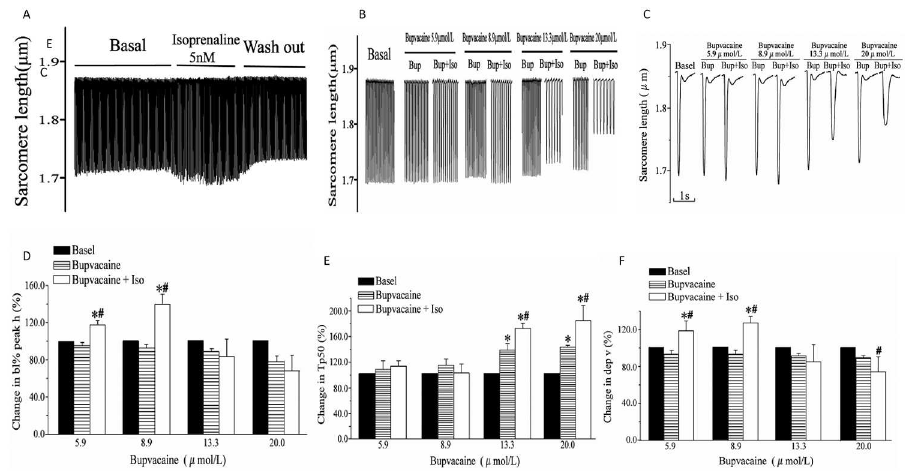
Fig 4. Effect of isoprenalin on bupivacaine-mediated depression of cardiomyocyte contractility. (A) Representative sarcomere-shortening trace before and after exposure to isoprenalin. (B) Representative sarcomere-shortening traces before and after exposure to bupivacaine with and without isoprenalin. Y axis: changing of sarcomere length during myocyte contraction; X axis: perfusates. (C) Representative individual signal of cardiomyocyte sarcomere shortening in the presence of bupivacaine, with and without 5.0 nmol/L isoprenalin. The signal was obtained by the averaging of ten successive signals. (D), (E) and (F) Statistical analysis of the effect of isoprenalin on bl% peak h, Tp50 and dep v in the presence of bupivacaine. Data are the mean ± SD. (cid:3) P < 0.05, vs . basal value; † P < 0.05, vs . bupivacaine group.